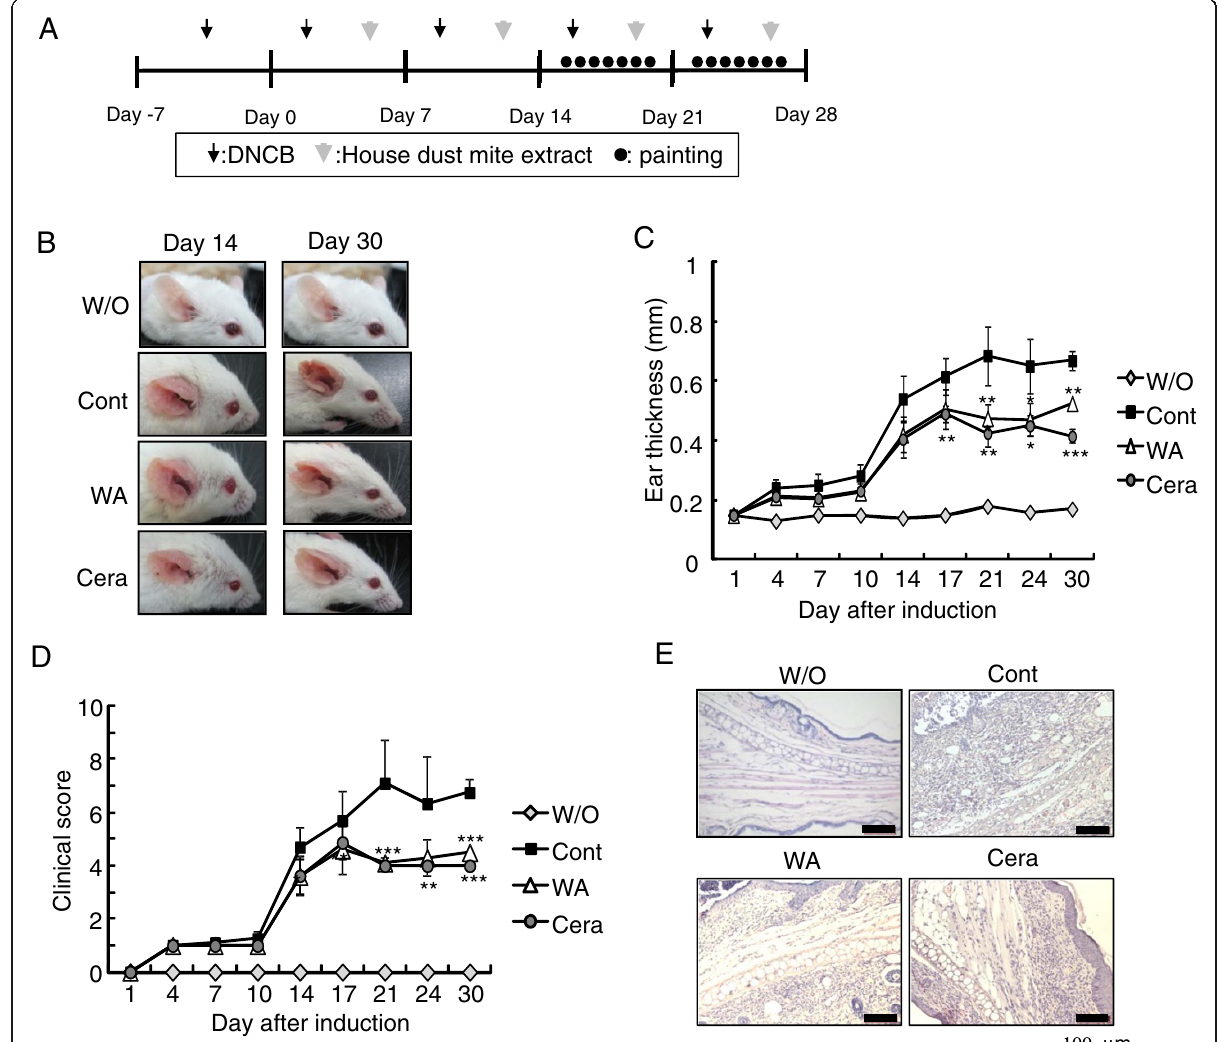
Figure 3 Topical application of water soluble extract of P. linteus improves the symptoms of experimental atopic dermatitis. ( A ) Experimental AD was induced on the both ears of BALB/c mice by alternative painting of DNCB (0.2 mg/each ear) and mite extract (0.2 mg/each ear) for 2 weeks. After 2 weeks of AD induction, control PBS (Cont) or water soluble extract of P. linteus (WA, 1 mg/each ear) or ceramide (Cera, 15 μ g/each ear) were painted daily for 2 weeks while continuously inducing experimental atopic dermatitis. ( B ) Representative mice of each treatment group at day 14 and day 30 are shown. During AD induction period, ear thickness ( C ) and clinical score ( D ) was measured 24 hrs after application of DNCB or mite extract. (E) Infiltrated lymphocytes into ears were observed by H&E staining. Error bars indicated S.D. One (*), two (**) and three asterisk (***) indicates P<0.05, P<0.005, P<0.001, respectively. Data are representative of three independent experiments. Without AD induction (normal health mice) is indicated as “ W/O ”